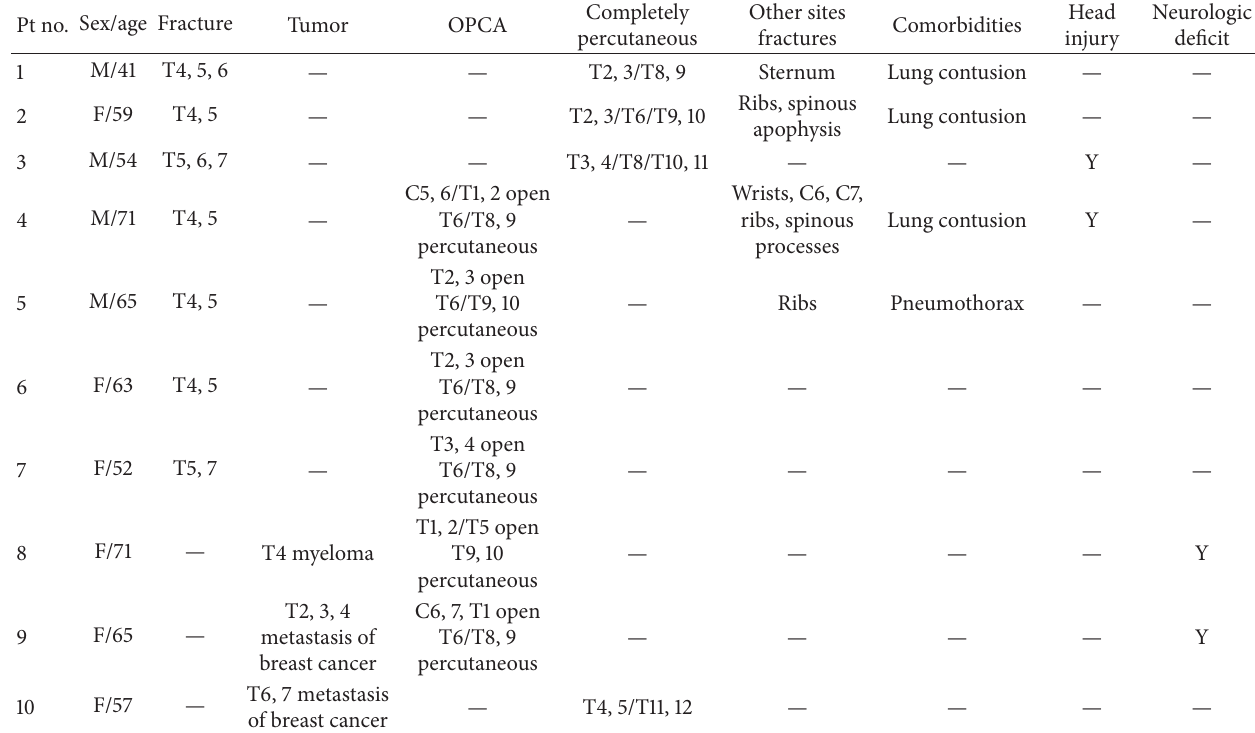
OPCA: open-percutaneous combined approach.